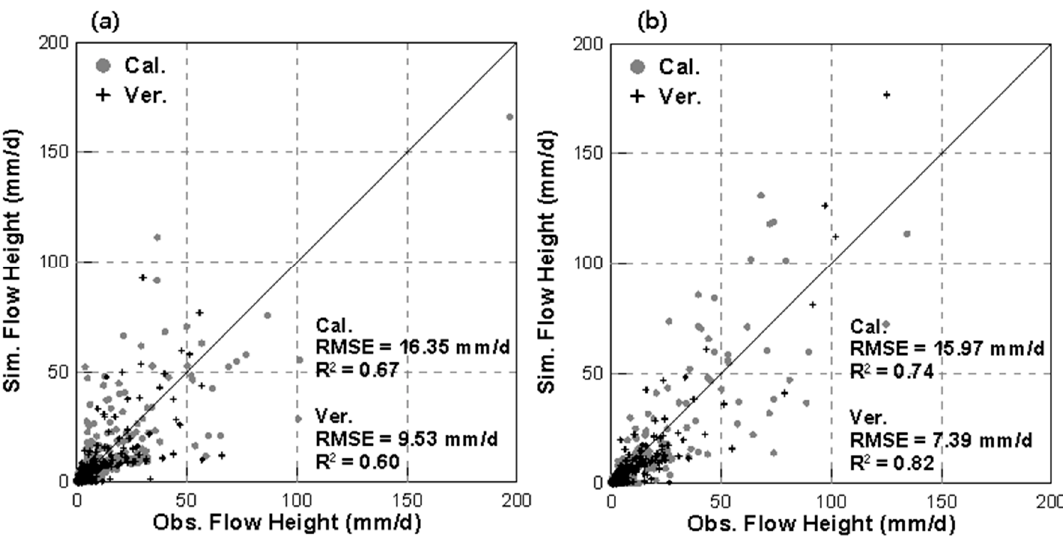
Figure 6. Scatter plots of observed flow height (x-axis) and model results (y-axis) for ( a ) Chungju Dam and ( b ) Soyanggang Dam. The flow height data for the calibration period are indicated with gray circles and verification period with black plus signs.